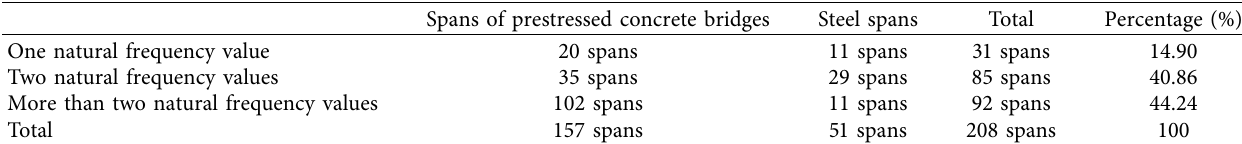
Table 12: Statistical quantities of natural frequency values of 38 bridges in district 2, district 9, and Thu Duc district.